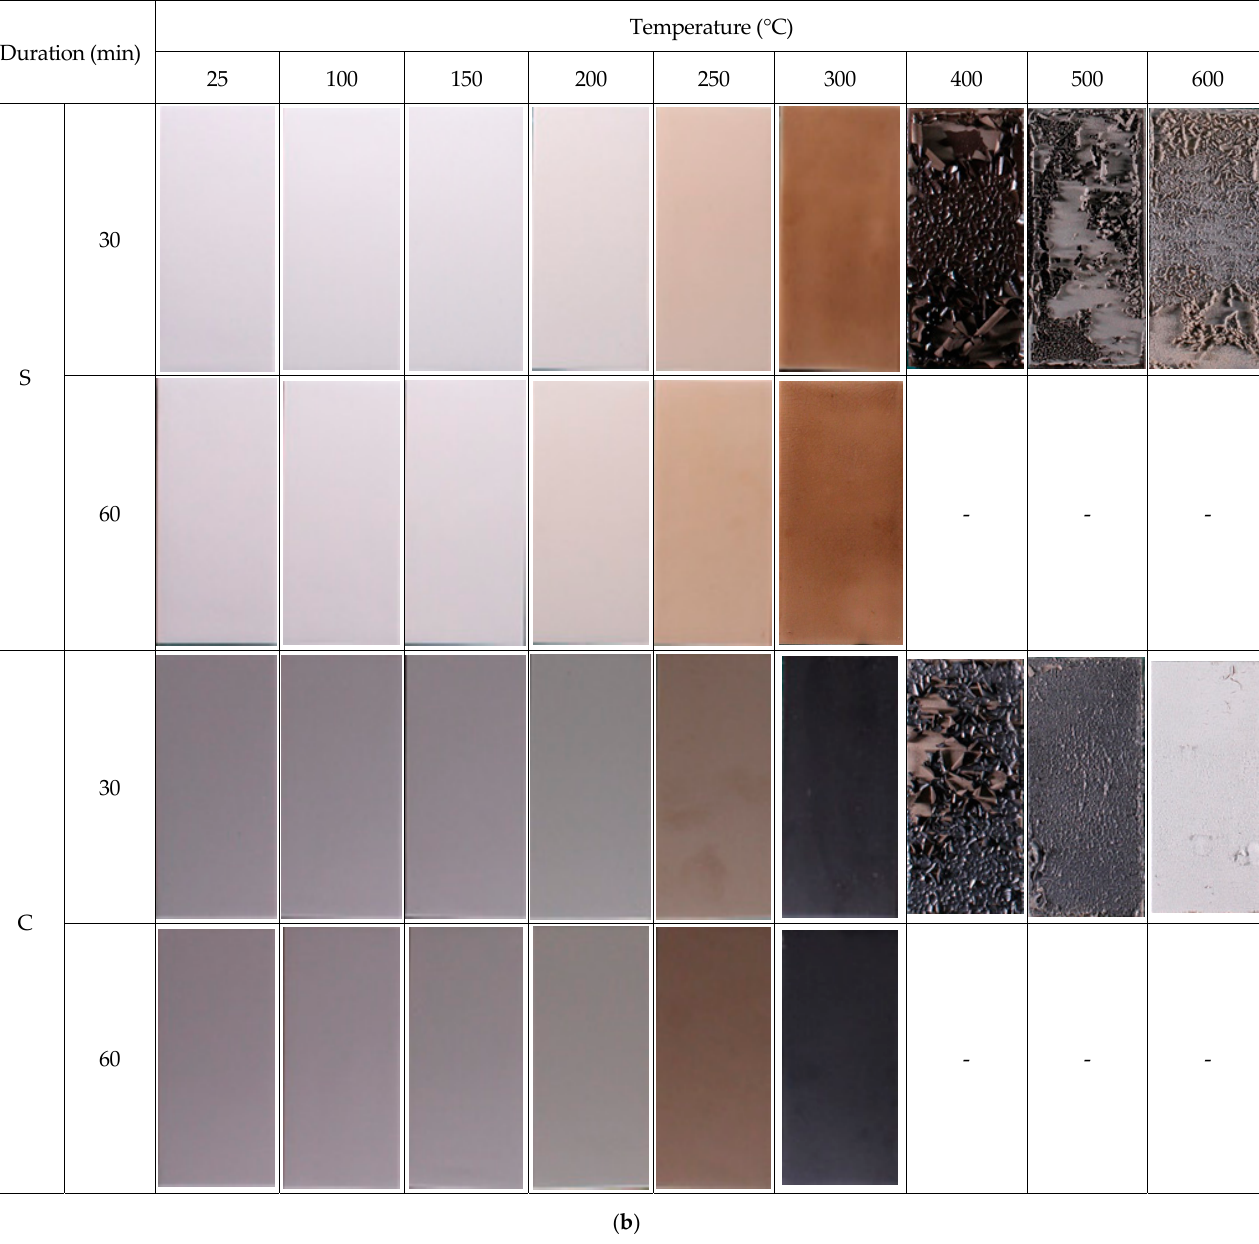
Figure 3. Surface conditions according to heating temperature and duration: ( a ) Urethane (U) and Fluorocarbon (F); ( b ) Siloxane (S) and Ceramic (C).